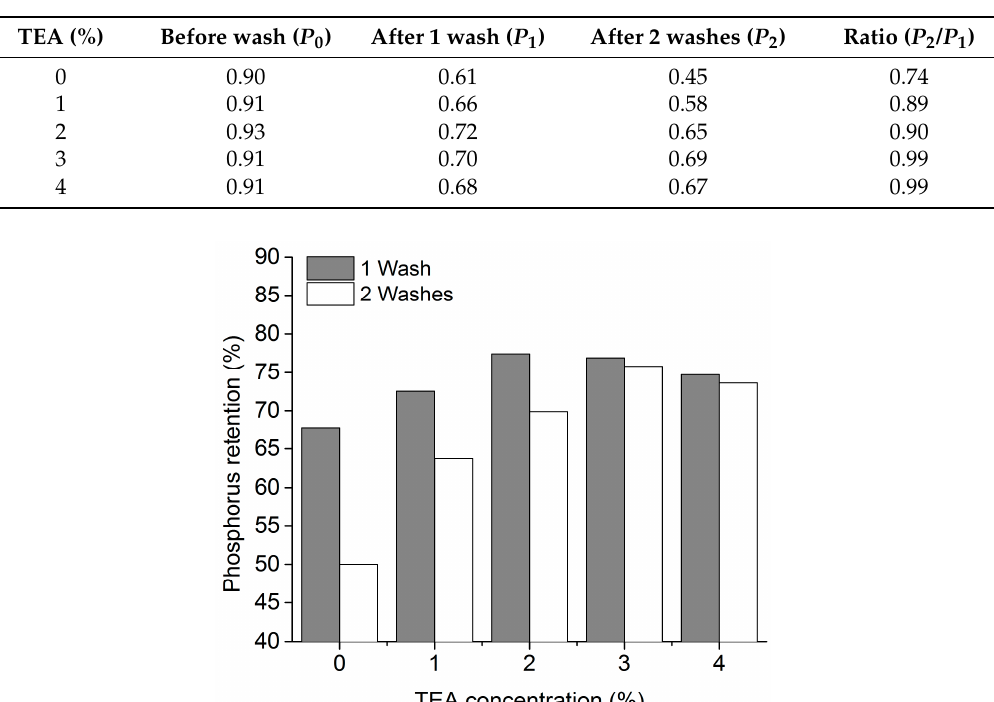
Table 6. The phosphorus concentration of the Nomex ® /cotton blend fabric treated with 12% HFPO, 3% BTCA and TEA with different concentration and cured at 170 °C for 3 min.